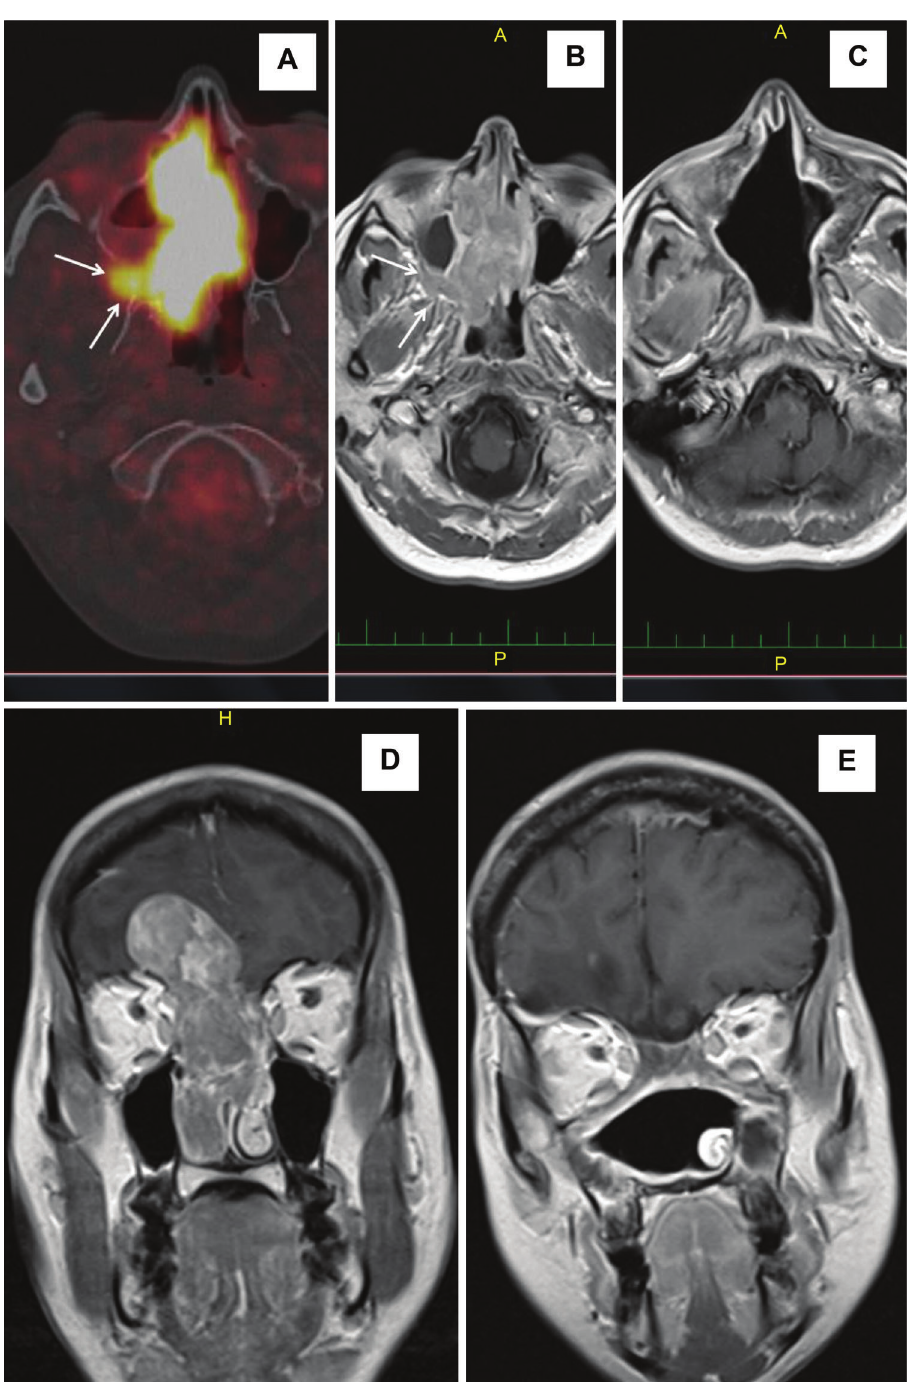
Figure 4 - Sinonasal undifferentiated carcinoma T4b, case P13. Axial PET/CT (A) and axial (B) and coronal (D) MRI T1-weighted with gadolinium contrast images showing a mass in the bilateral nasal cavities, bilateral ethmoid sinuses, right maxillary and sphenoid sinuses, and right pterygopalatine fossa (arrows) with an intracranial portion with brain infiltration. Axial (C) and coronal (E) MRI T1- weighted scans with gadolinium contrast demonstrating no evidence of disease two years after surgery and postoperative